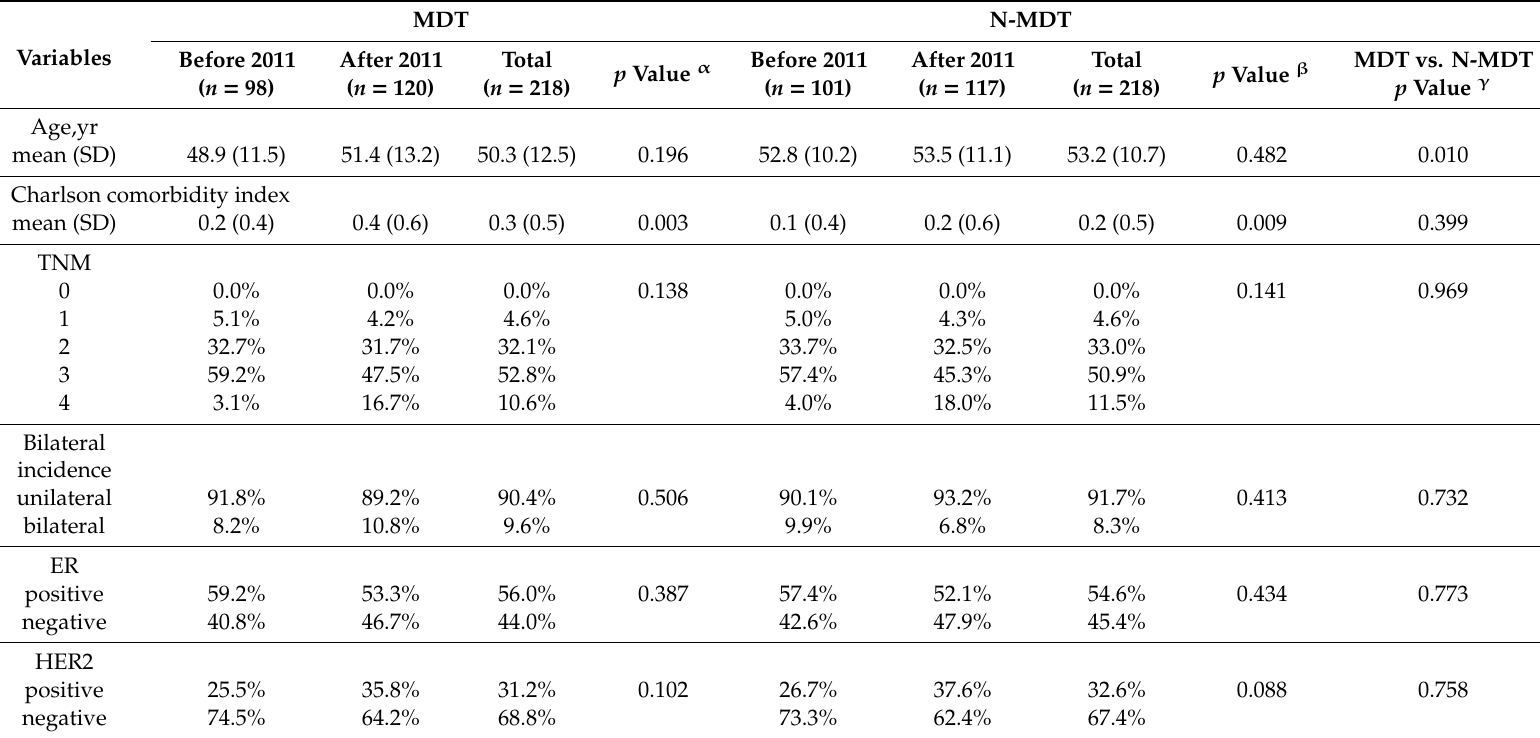
Table 3. Basic characteristics of post-PSM of the sample